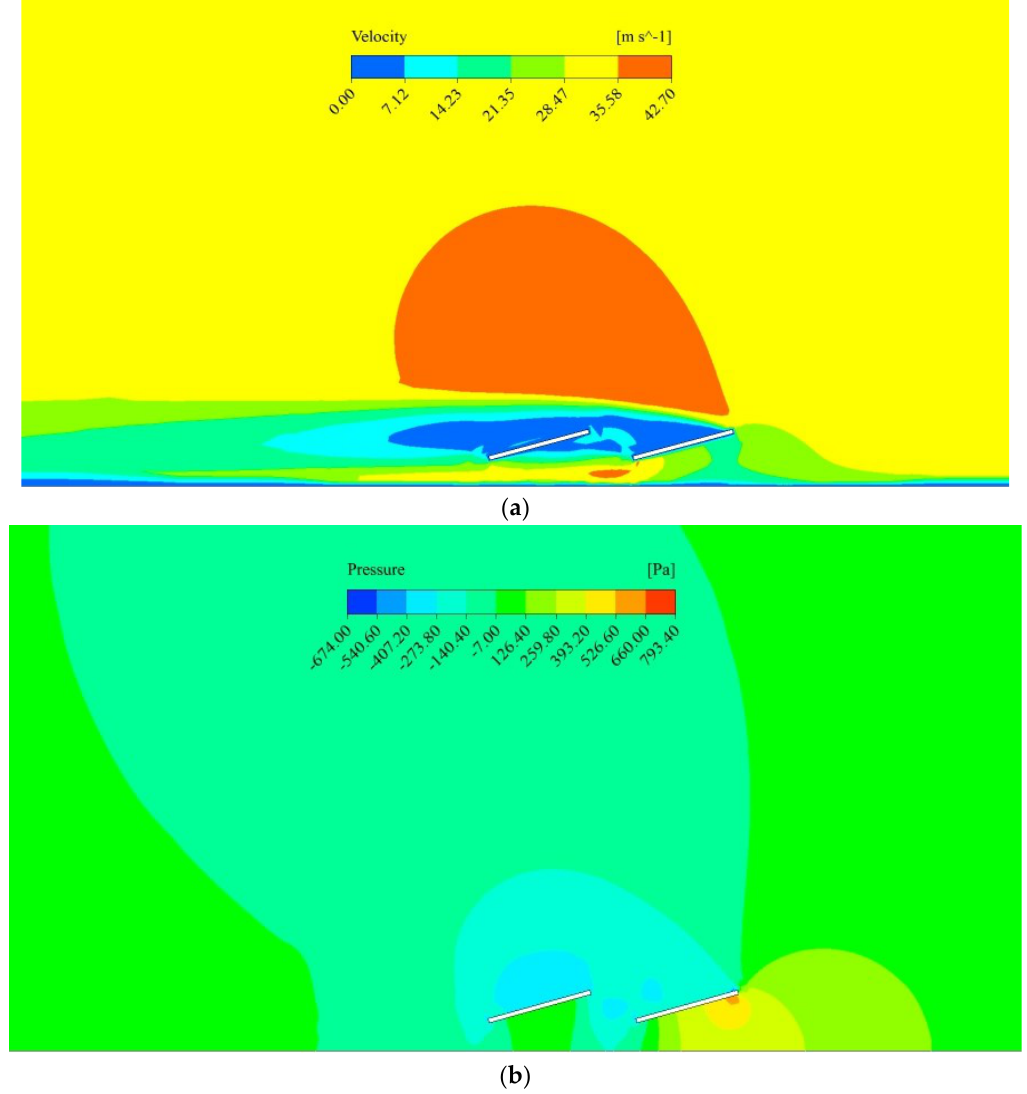
Figure 9. Case II — CFD simulation results for optimum configuration ( a ) velocity contour; ( b ) pressure